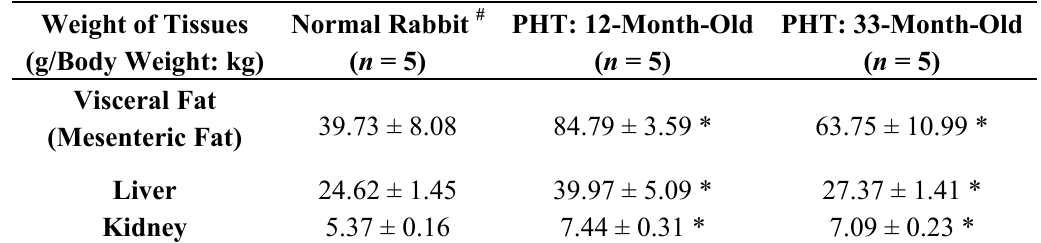
Table 1. Comparison of the weights of visceral fat, liver and